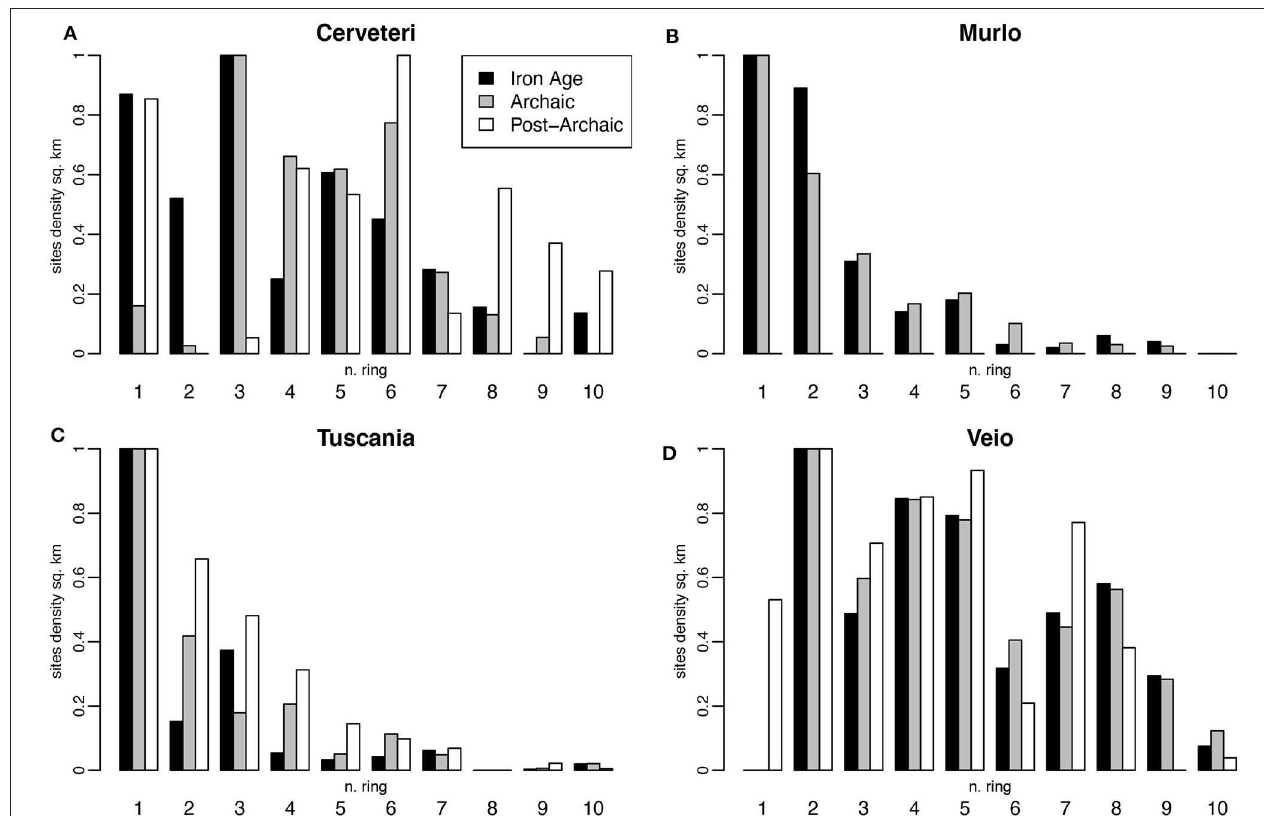
FIGURE 13 | Normalized sites density at increasing distance (concentric rings) from Cerveteri (A) , Murlo (B) , Tuscania (C) , and Veio (D) . Murlo was not occupied in the Post-Archaic period.